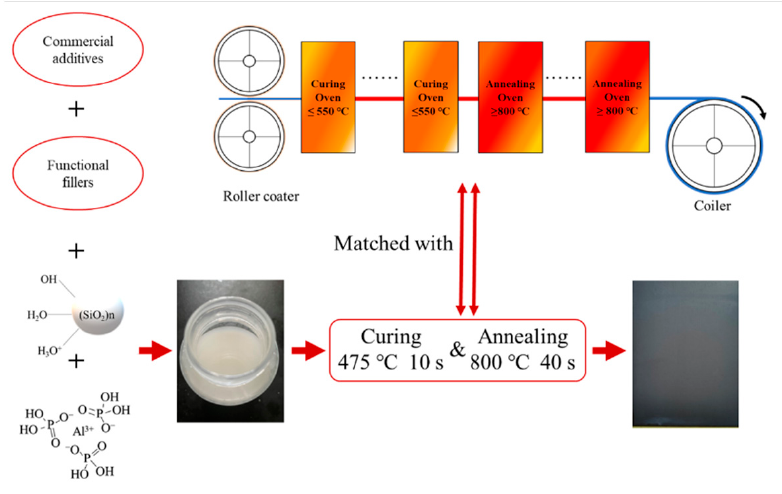
Figure 3. The schematic diagram of in situ curing process.